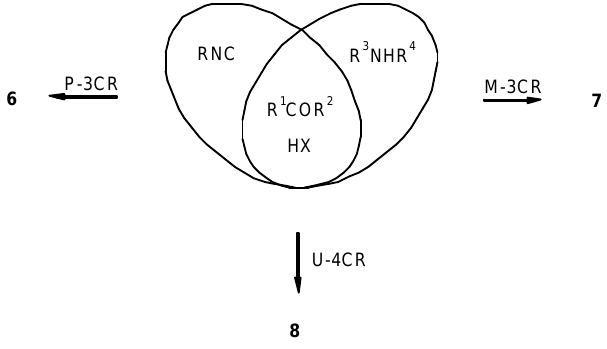
Scheme 5: The U-4C as a union of HO-3CR and P-3CR.